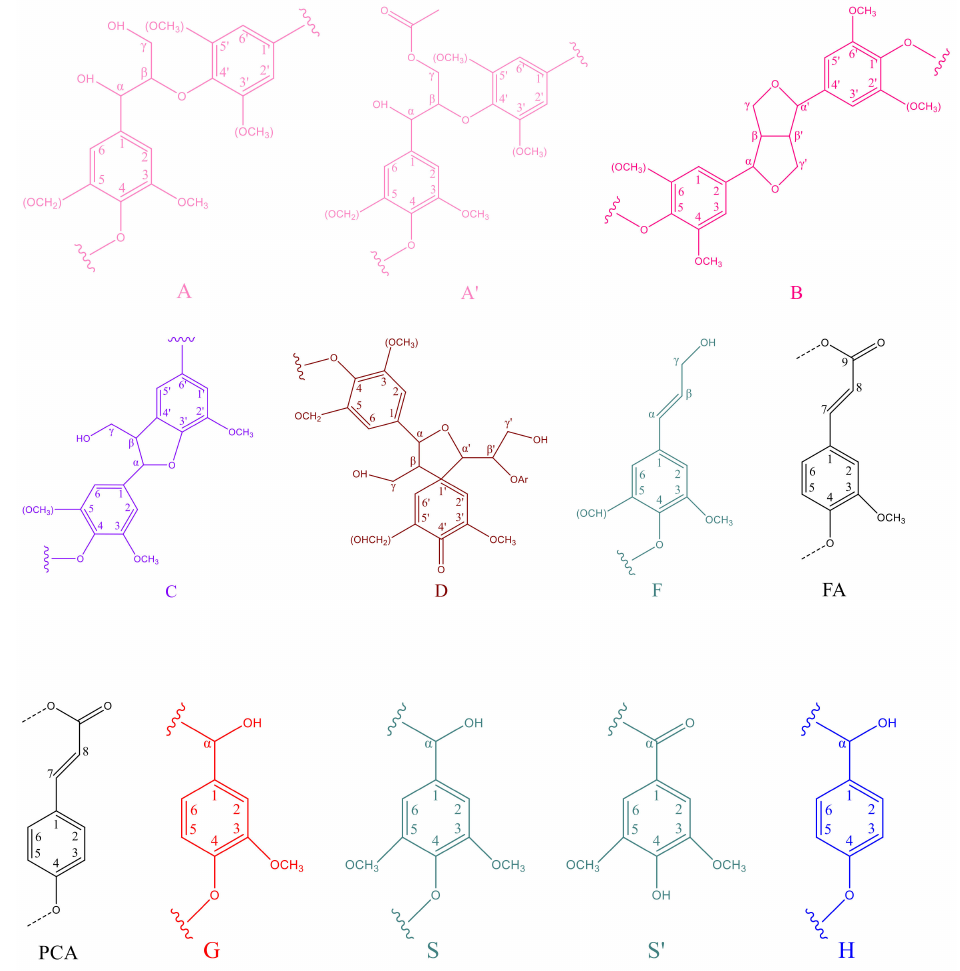
Figure 4. The main substructure of the isolated lignin analyzed by HSQC-NMR. A and A’ is different in the functional group in C γ position. S and S’ is different in the functional group in C α